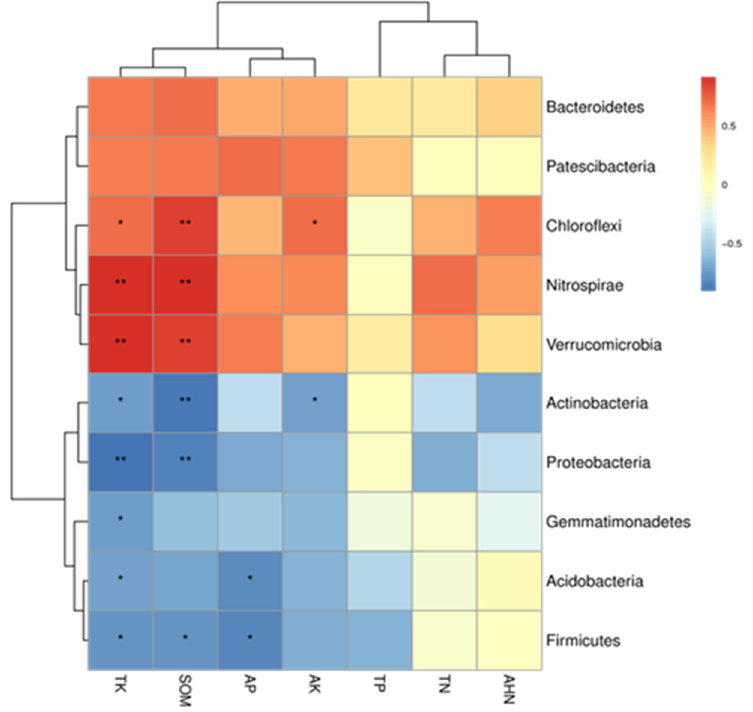
Figure 7. Effects of soil nutrients on the bacterial community composition. CK, conventional fertilizer; BC, biochar with conventional fertilizer. SOM, soil organic matter; TN, total nitrogen; TP, total phosphorus; TK, total potassium; AHN, alkaline hydrolysable-nitrogen; AP, available phosphorus.